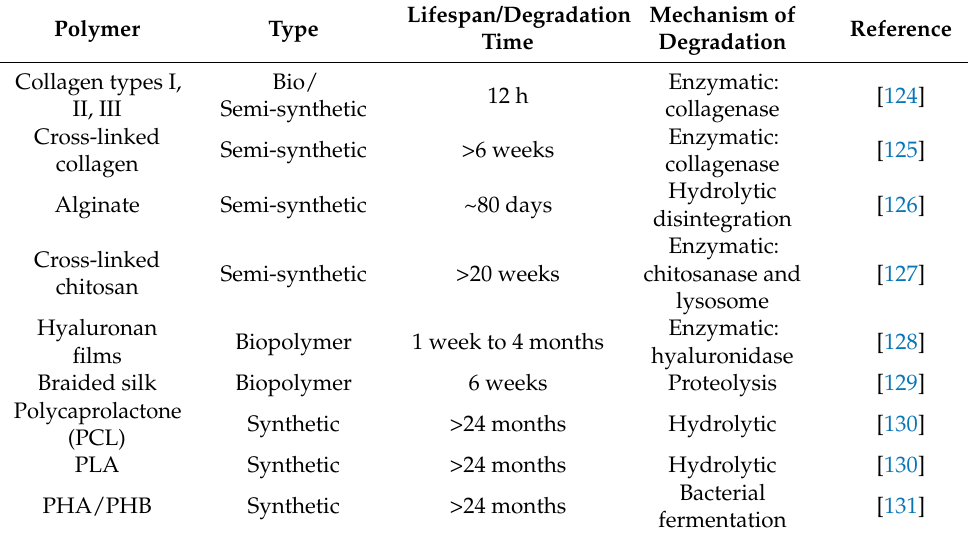
Table 4. Comparative analysis of biopolymers and synthetic